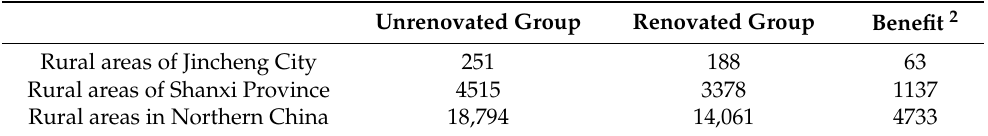
Table 2. Number of excess deaths (person) 1